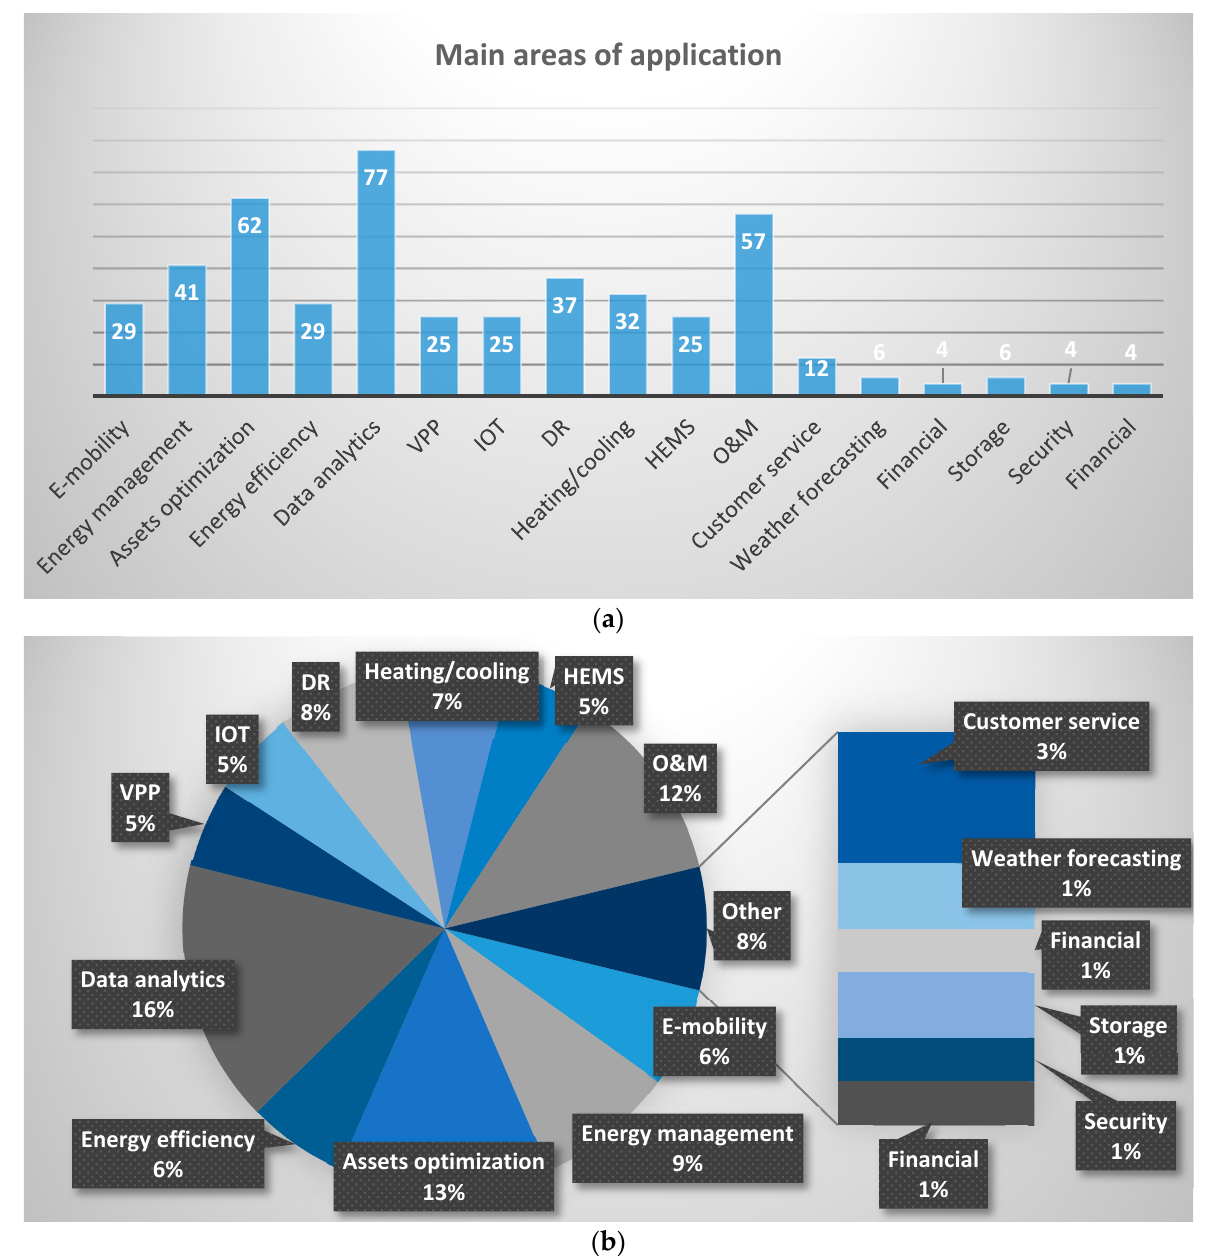
Figure 8. ( a ) Main areas of application of AI companies in the power sector. ( b ) Main focus areas of AI companies in the power sector.